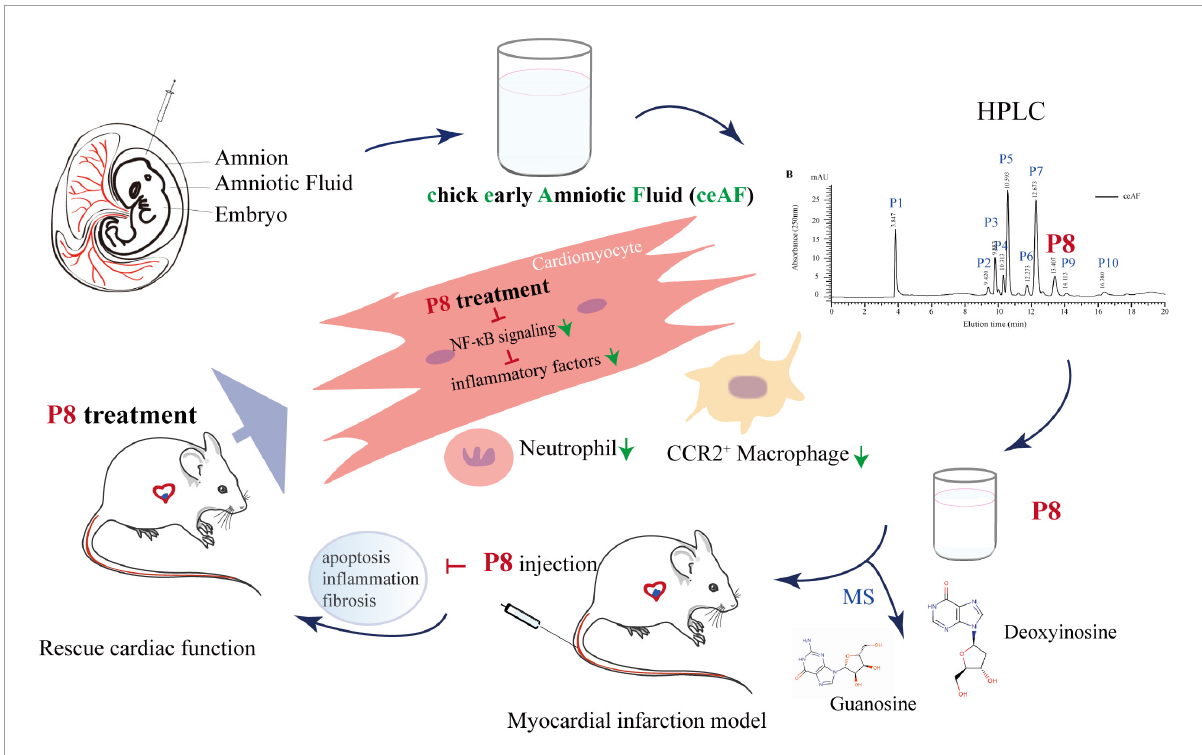
FIGURE8 Hypothetical model of P8 in improving heart function in MI mice. ceAF main active component P8 improves cardiac function in MI mice via downregulating NF- κ B signaling and inflammation-related gene expression, decreasing infiltration of neutrophils and CCR2 + macrophages, and reducing cardiomyocytes apoptosis and cardiac